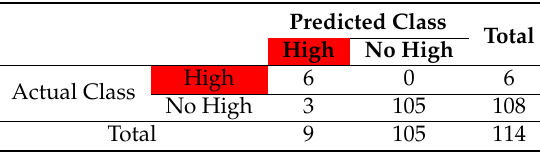
Table 8. Binary contingency table for the class (of exposure) High.